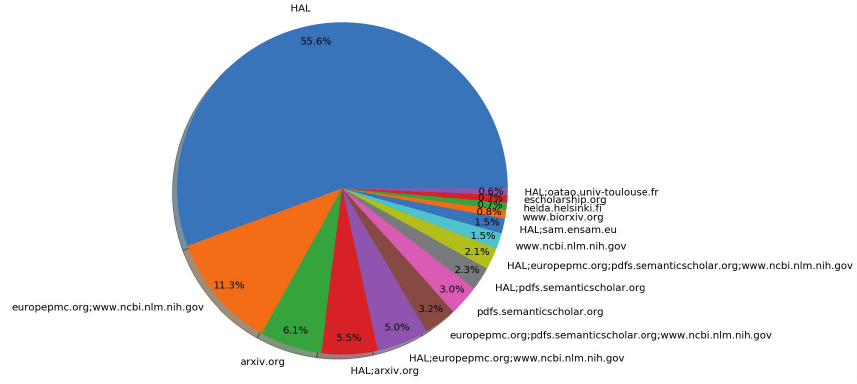
Fig. 7: Ranking of the most represented open archives in